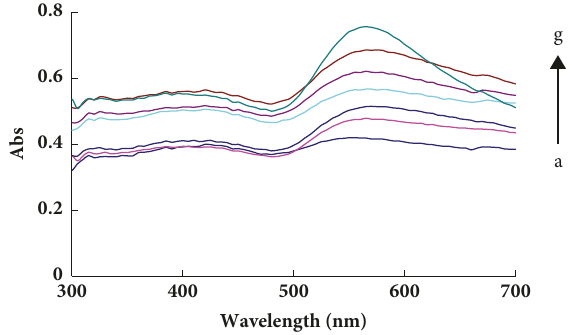
Figure 3: Absorption spectra of CH 3 CH 2 OH-Na + -PA-GONR- H 2 O 2 -HAuCl 4 system. a:1.13 mol/L CH 3 CH 2 OH+ 3.14 𝜇 mol/L CAP+0.193 mmol/L HAuCl 4 +3.3 mmol/L H 2 O 2 +23.8 ng/mL GONR; b:a+0.69 nmol/L Na + ; c:a+4.3 nmol/L Na + ; d:a+8.6 nmol/L Na + ; e:a+12.9 nmol/L Na + ; f:a+17.2 nmol/L Na + ; g:a+25.8 nmol/L Na +